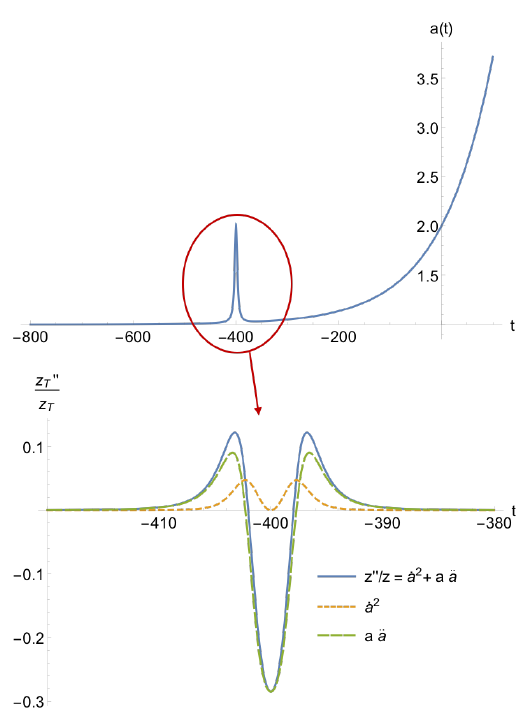
Figure 3. ( First panel ) Scale factor evolution with one bounce characterized by C 1 = 1, µ = − 400, σ = 2, and B = 0.4. ( Second panel ) Tensor potential around the bounce.